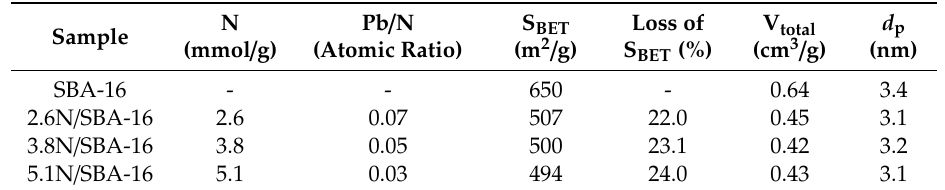
Table 2. Unit cell parameter ( a o ), and pore wall thickness ( w t ) of the bare SBA-16 and amine-functionalized adsorbents.